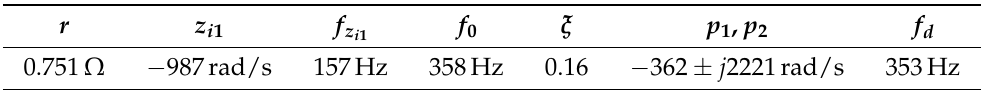
Table 4. Parameters of T pi of the DC–DC boost